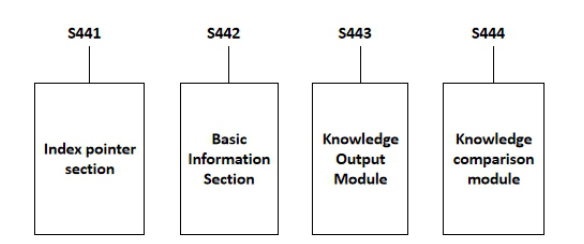
Figure 8. Composition of Location Security Knowledge